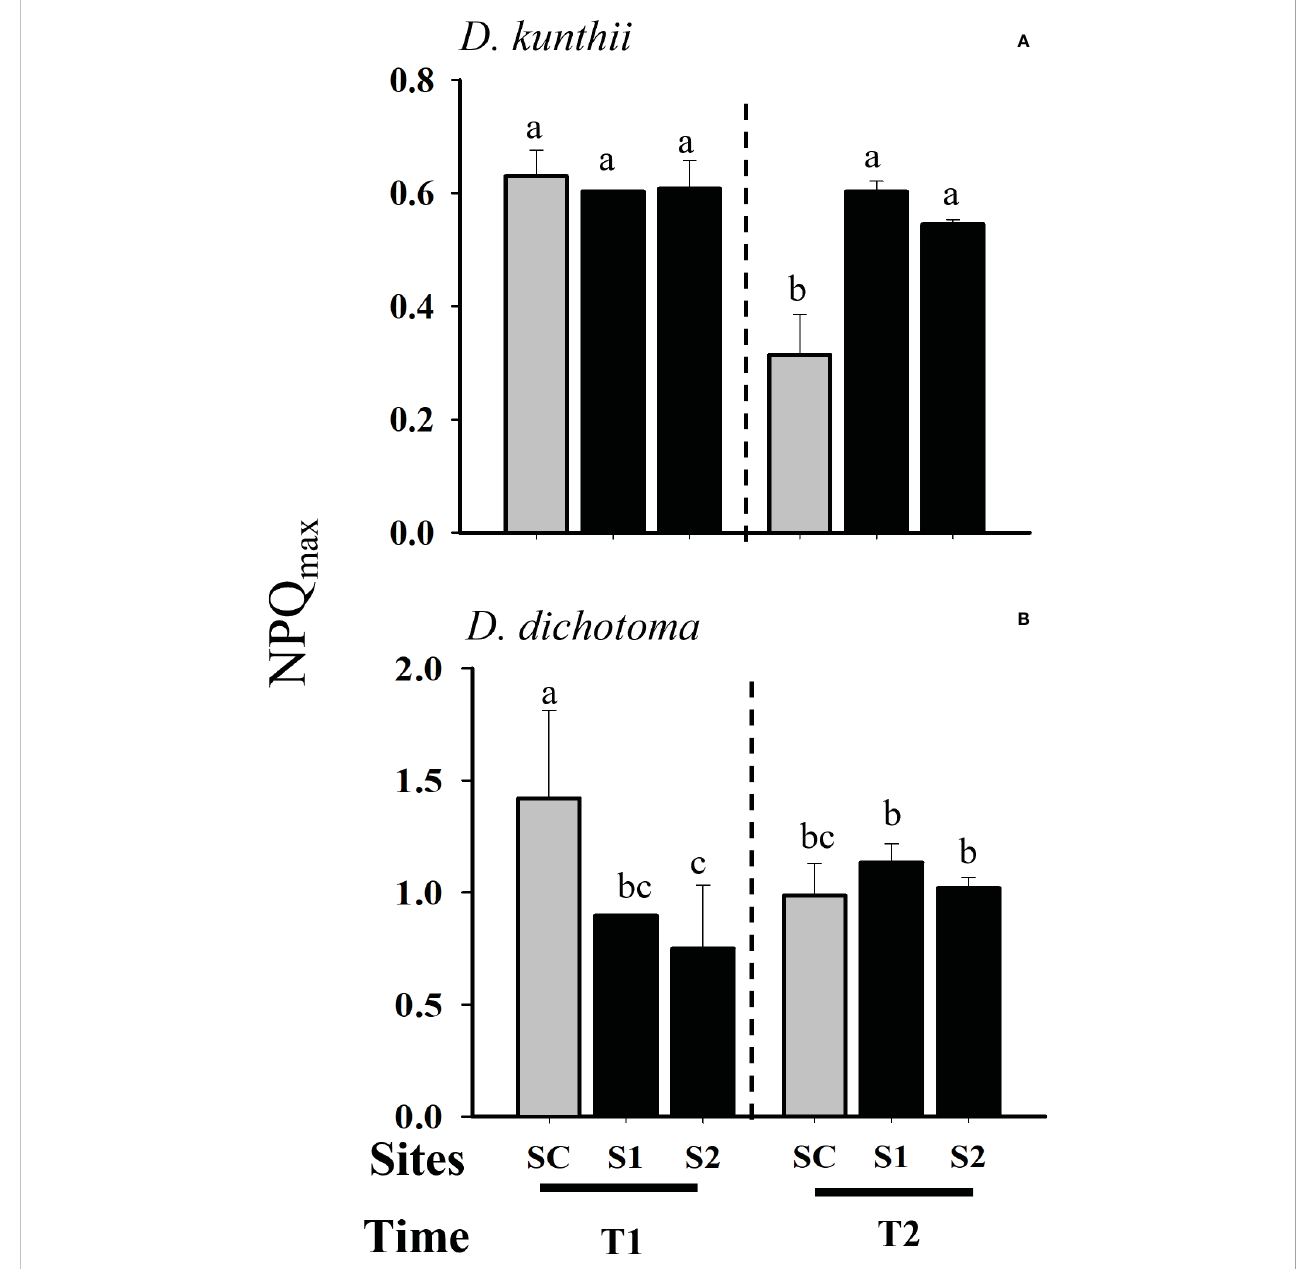
FIGURE 4 Photosynthetic responses as Maximal non photochemical quenching (NPQ max ) in D. kunthii and D. dichotoma transplants under the in fl uence of brine discharge from a desalination plant. In D. kunthii , NPQ max (A) was measured at 2 impacted sites with low (S1) and high (S2) in fl uence from a brine discharge from a desalination plant located in Antofagasta, Chile, and using a control site (SC) at 3 (T1) and 7 (T2) days. In D. dichotoma , NPQ max (B) were measured at 2 impacted sites with low (S1) and high (S2) in fl uence from a brine discharge of a desalination plant located in Alicante, Spain, using a control site (SC) at 3 (T1) and 6 (T2) days. Data corresponds to mean ± SD ( n = 3). Letters represent statistical difference at 95% con fi dence interval (SNK test, p <